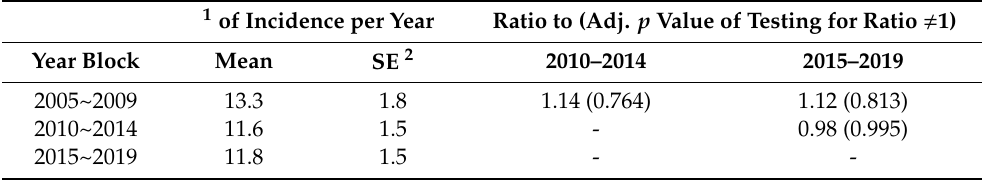
Figure 2. Incidence of acute cytauxzoonosis cases by year. Numbers represent raw acute cytauxzoonosis case counts. Table 1. Statistical analysis of year block effect on acute cytauxzoonosis incidence. 1 of Incidence per Year Ratio to (Adj. p Value of Testing for Ratio ≠ 1)